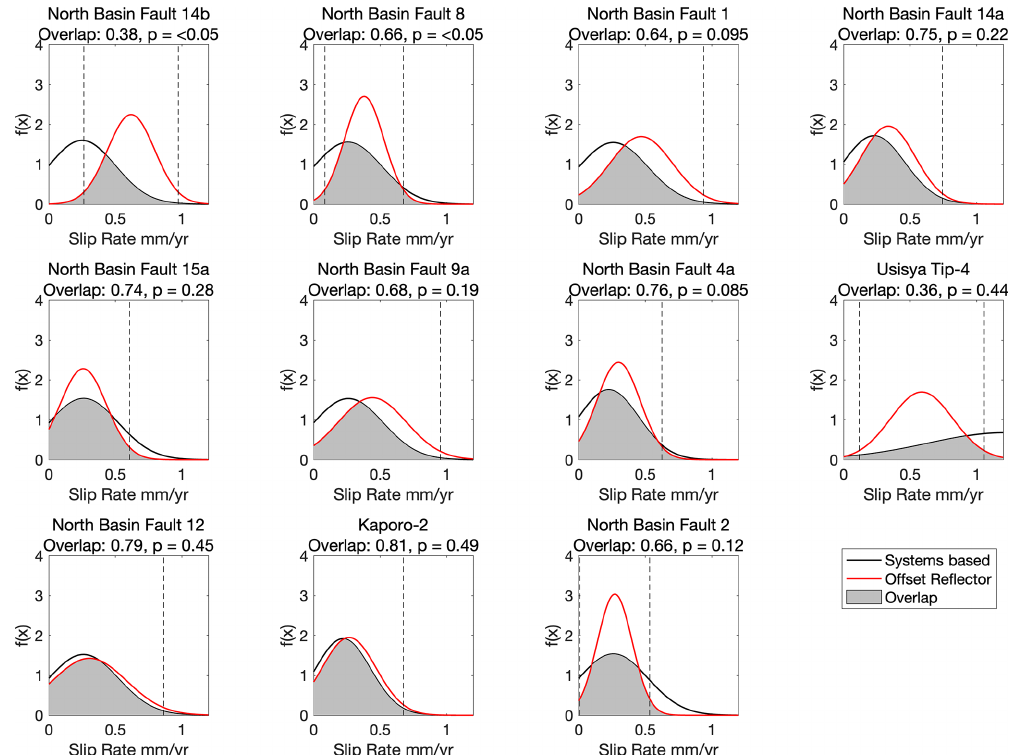
Figure 9. Comparison of the slip rate probability distribution for 11 intrarift faults in the North Basin of Lake Malawi when derived from the systems-based approach and offset seismic reflector (Shillington et al., 2020). Dashed vertical lines indicate 2 standard deviations about the mean value of the offset–reflector slip rate distributions. For each plot, we report the overlap coefficient (OVL) between the two probability distributions (Eq. 6) and the p value from a two-sample χ 2 test on 600 samples randomly drawn from these distributions. The χ 2 test accepts the null hypothesis that there is no difference in these samples when p > 0 .